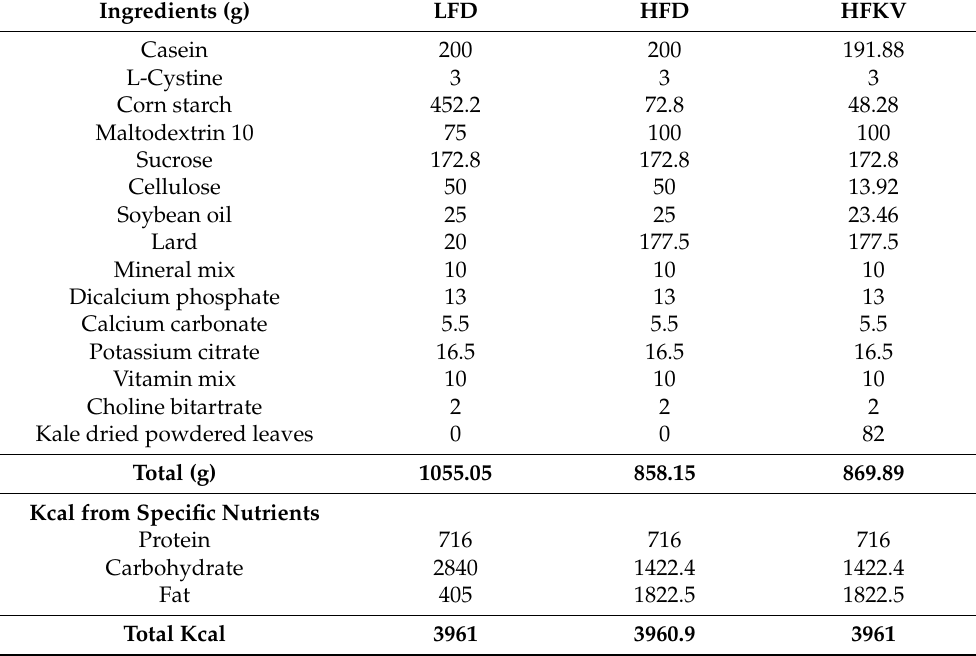
Table 2. Diet formulations used in this